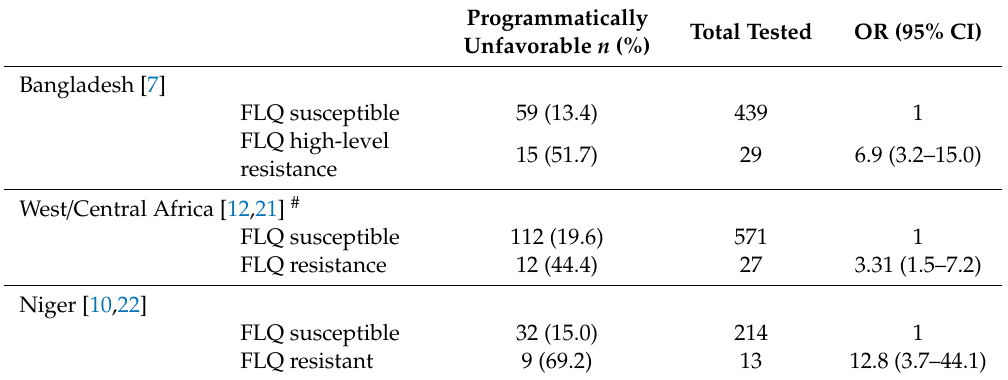
Table 3. Association between initial resistance to fluoroquinolone and programmatically unfavorable outcomes. Programmatically